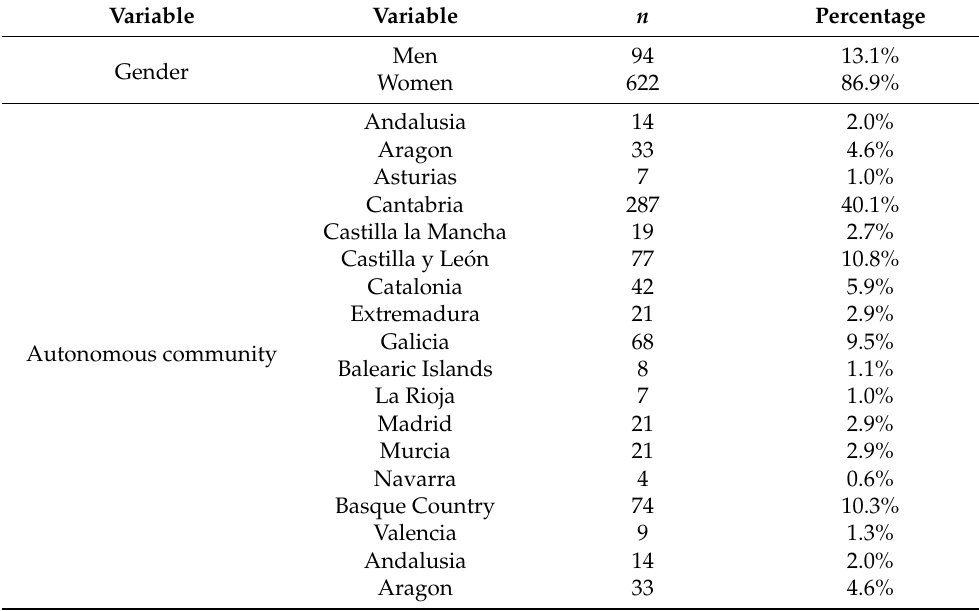
Table 1. Sociodemographic descriptive variables of the whole